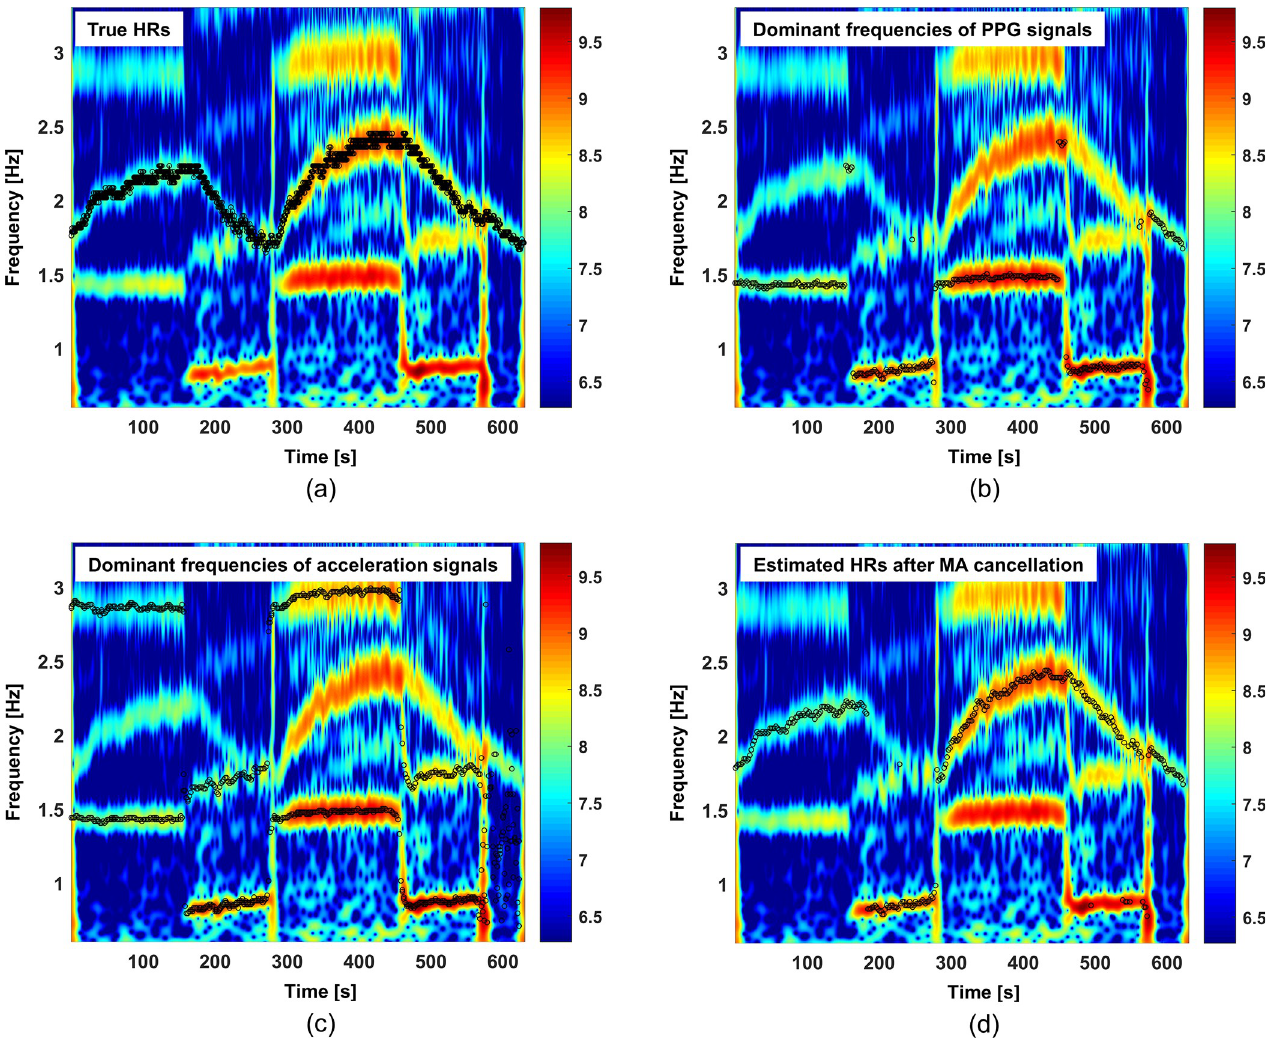
Fig 2. Time-frequency spectrum (TFS) of the PPG signals for subject 1 obtained by the BAMI device. (a) true HRs (black circles) on the TFS, (b) dominant frequencies of the PPG signals (black circles) on the TFS, (c) dominant frequencies of the three-axis acceleration signals (black circles) on the TFS, and (d) dominant frequencies of the PPG signals (black circles) on the TFS after MA cancellation using the acceleration signals.